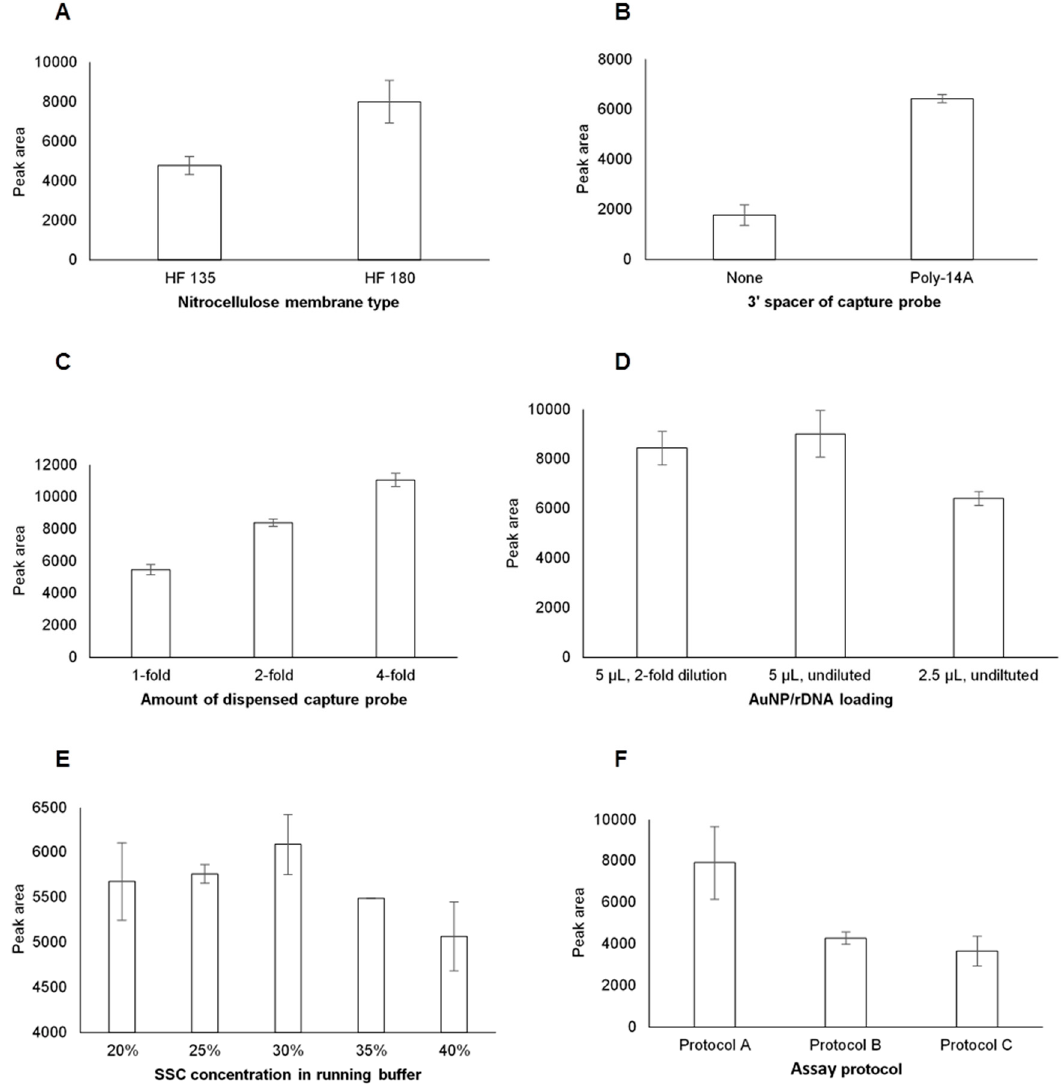
Figure 2. Optimization of LFB parameters. ( A ) Effect of NC membrane type on the signal of LFB; ( B ) Effect of added poly-14A on the signal of LFB; ( C ) Effect of dDNA concentration on the signal of LFB; ( D ) Effect of AuNP/rDNA loading on the signal of LFB; ( E ) Effect of SSC buffer concentration on the signal of LFB; ( F ) Effect of assay protocol on the signal of LFB.